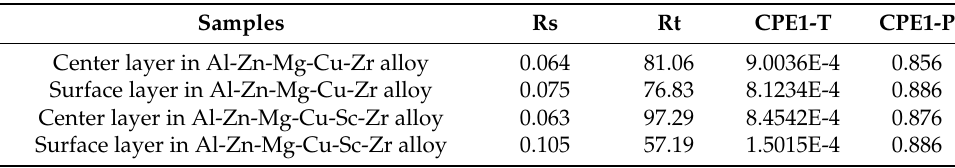
Table 5. Electrochemical parameters obtained by fitting analysis of